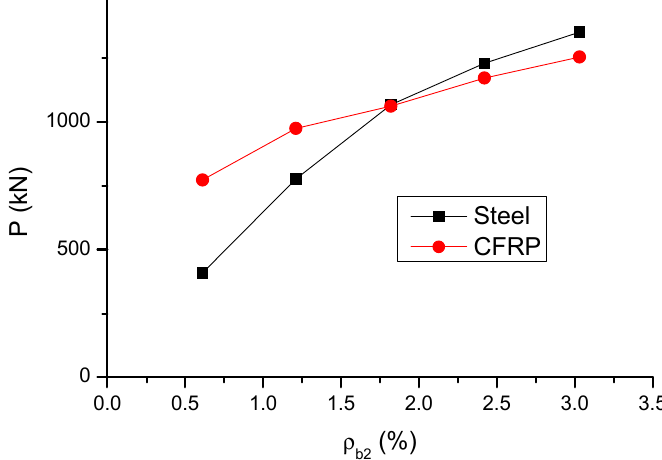
Figure 9. Variation of ultimate load with varying bar ratio.